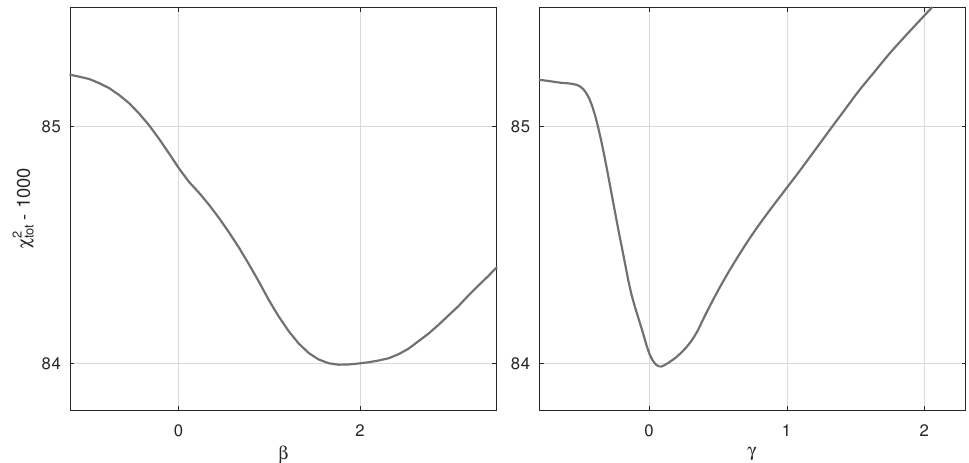
Figure 3. The generalized model (25) with all H ( z ) data: one-parameter distributions for β and γ . We see in Figure 3 that the absolute minimum for the generalized model (25) min χ 2 1084.0 is achieved near the point β = 2, γ = 0. One may conclude that the Barboza–Alcaniz– Zhu–Silva (BAZS) model [25] (corresponding to γ = 0) with Ω x ( a ) (21) and β = 2 appeared to be the most successful for the considered observational data Ia + CMB + CC + H BAO .